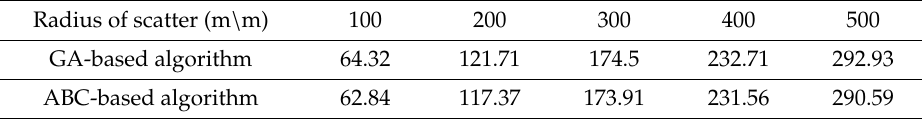
Table 1. Average location errors versus the radius of scatters.